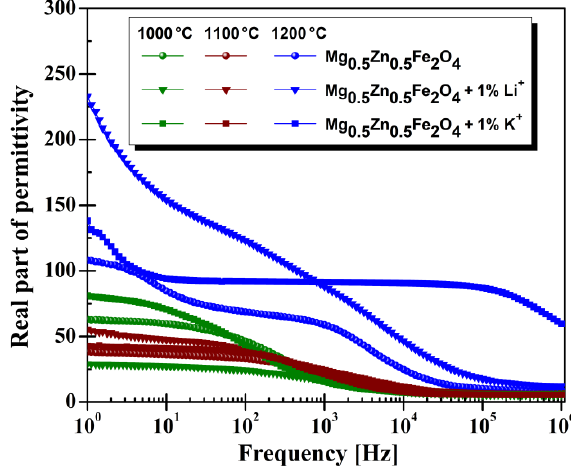
Figure 5. Dielectric characteristics of the Mg-Zn ferrites.